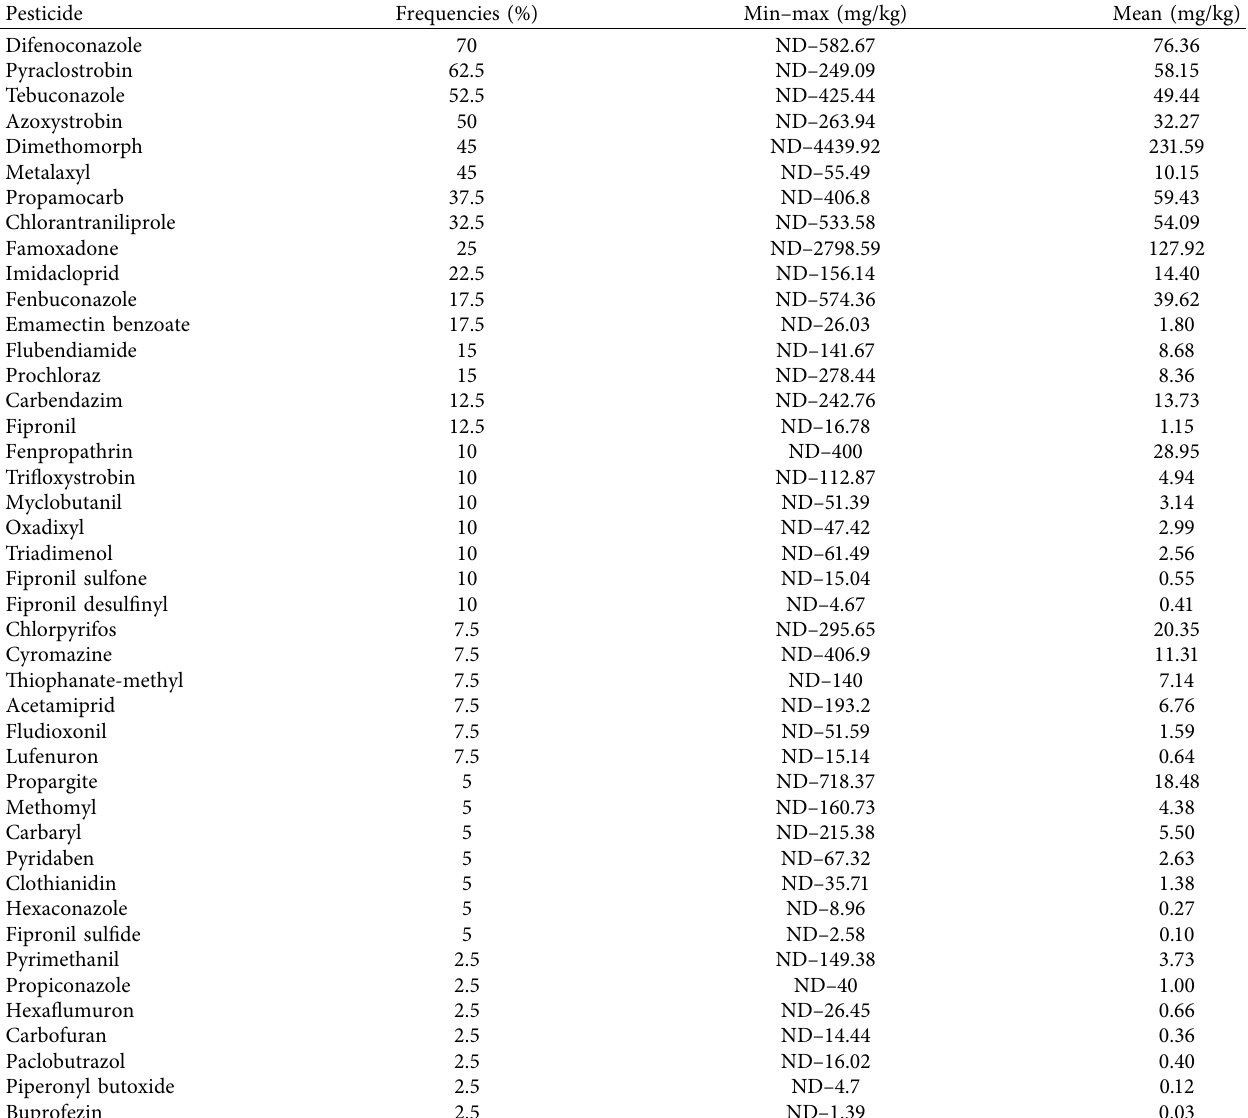
Table 2: Frequencies and residue levels of detected pesticides in D. officinale